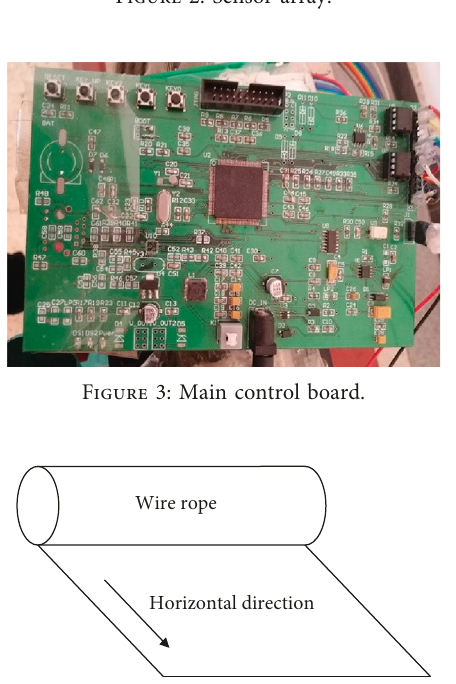
Figure 2: Sensor array.